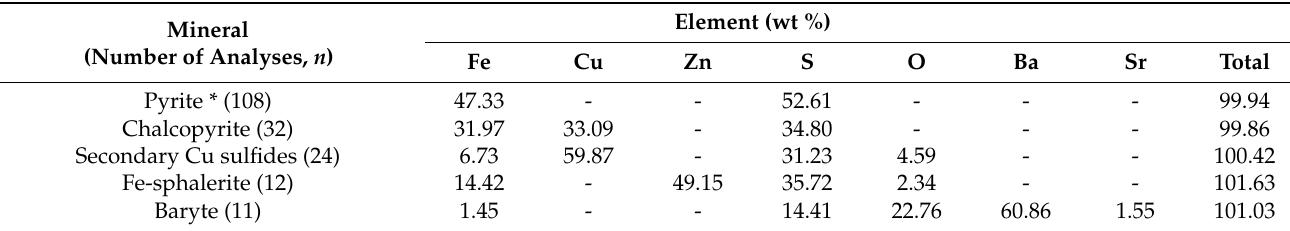
Table 6. Average chemical composition of sulfides from st. 373.